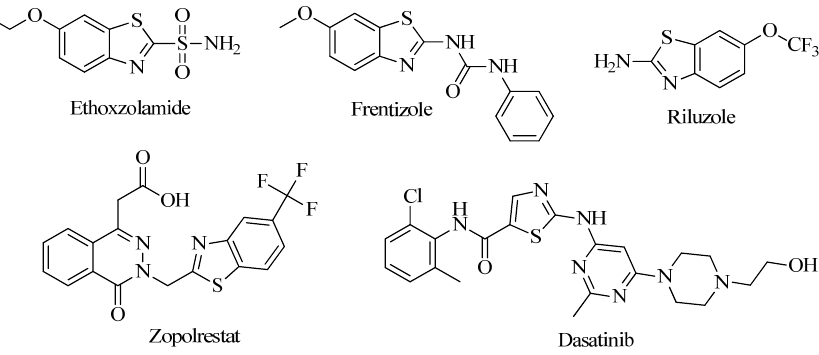
Figure 1. Benzothiazole- and phthalazine-based approved drugs.